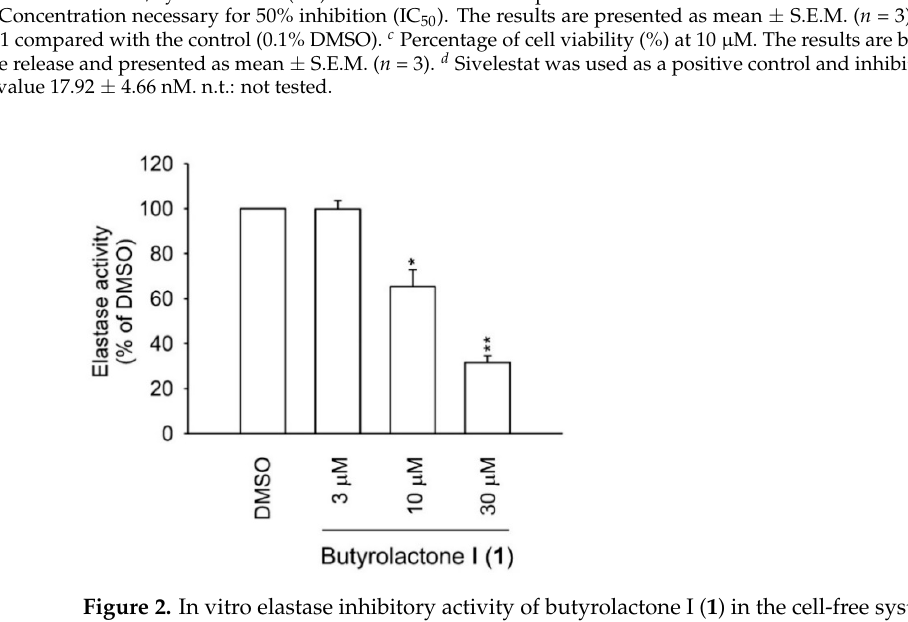
Figure 2. In vitro elastase inhibitory activity of butyrolactone I ( 1 ) in the cell-free system. The re- sults are presented as mean ± S.E.M. ( n = 3). * p < 0.05, ** p < 0.01 compared with the control (0.1% DMSO).